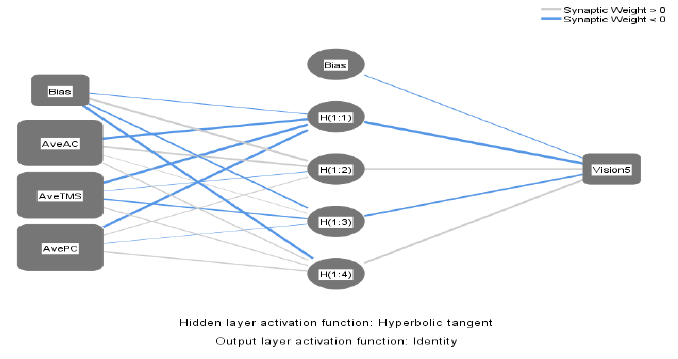
Fig. 2. MLP Model-Vision